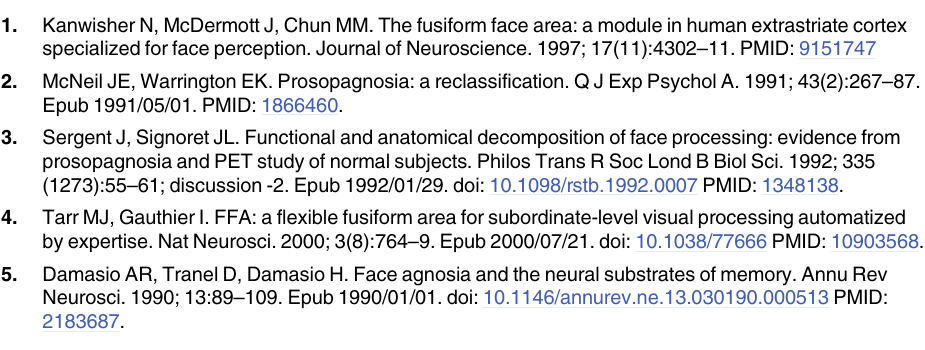
S2 Table. Results of the Famous Face/House Recognition Test (FFHRT). Reaction time (ms) and accuracy (percent correct) are significantly different for famous faces between groups whereas performance for unfamiliar faces and houses is statistically indistinguishable. S3 Table. Bivariate Pearson ’ s Correlations between different tests of face perception and recognition. Performance measures in the BFRT, the CMTF and the FFHRT are significantly correlated whereas performance in the RMT only shows a significant correlation with the BFRT. Numbers without brackets denote correlation coefficients; those with brackets denote level of significance. S4 Table. Bivariate Pearson ’ s Correlations between M170 amplitudes and latencies in para- digm 1 and 2. As can be taken from S2 and S3 Figs controls and people with cPA scatter around the diagonal. Therefore, as an indicator for the general stability of results in the control experiment the correlations were computed for both groups together. Most resulting correla- tions are of high strength and significance. Correlations between house evoked M170 latencies are slightly weaker, the reason being that due to smaller amplitudes of house evoked M170 amplitudes in some instances the peaks were less well defined which resulted in higher estima- tion uncertainty and